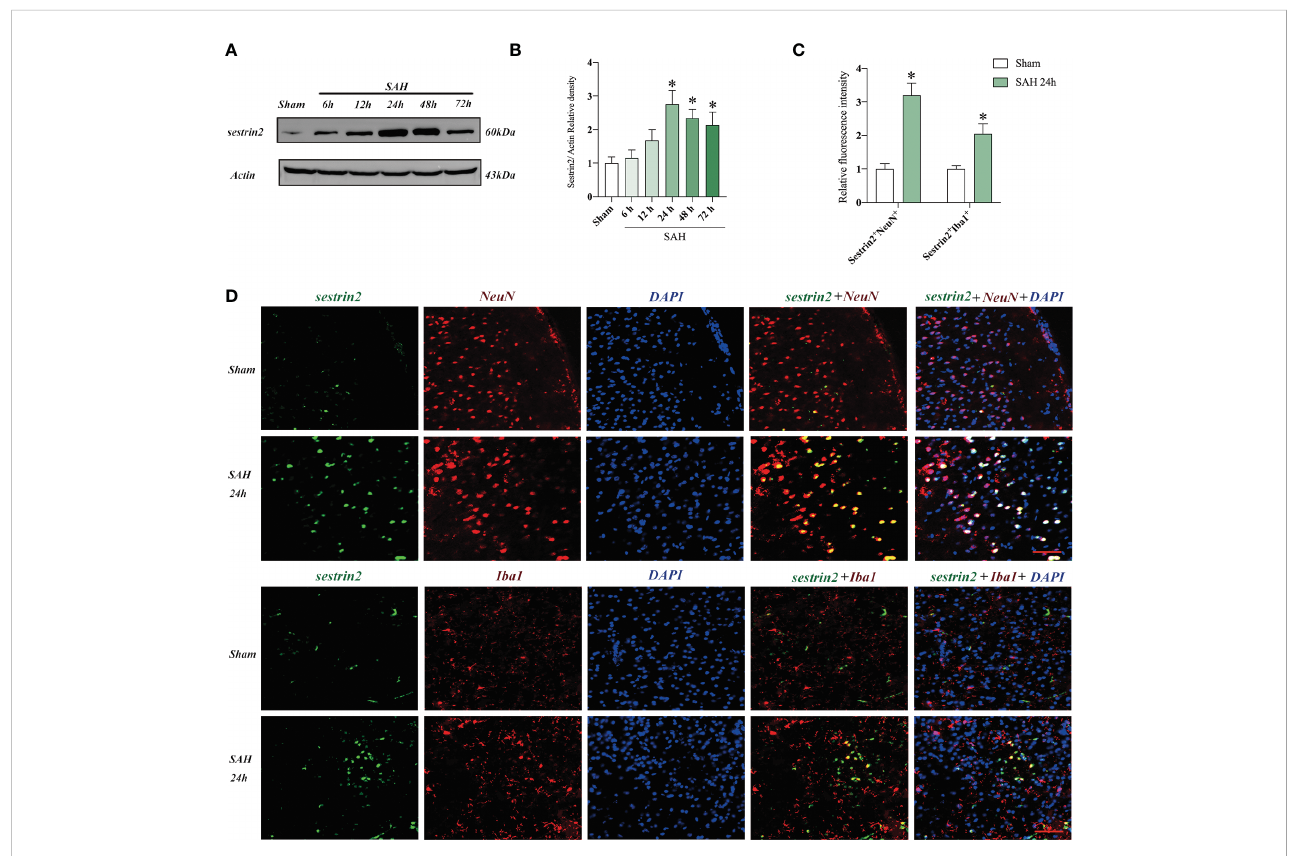
FIGURE 1 Expression and cellular distribution of sestrin2 in the early period after SAH. (A) Representative western blot bands and (B) quantitative analysis of sestrin2 in different groups (n = 6 per group). (C) Quantitative analysis of sestrin2 in neurons and microglia in sham and SAH groups (n = 6 per group). (D) Double immuno fl uorescence staining for sestrin2 in neurons and microglia in the brain cortex after SAH. * P < 0.05 versus sham group. Data indicated as mean ± SD. Scale bars = 50 m